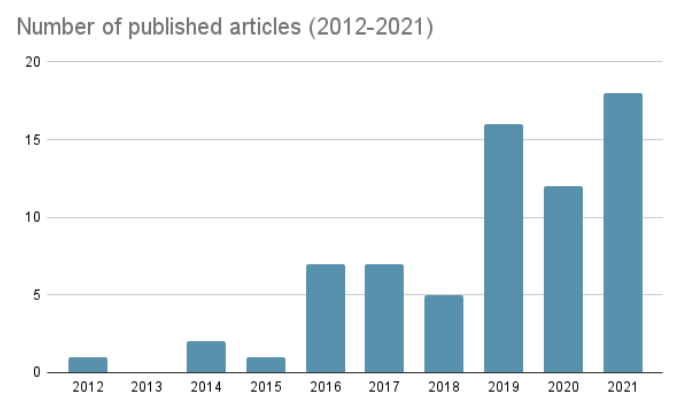
Figure 2. Graphical representation of the number of articles included in this review: This bar plot depicts the papers included in this review according to their publishing